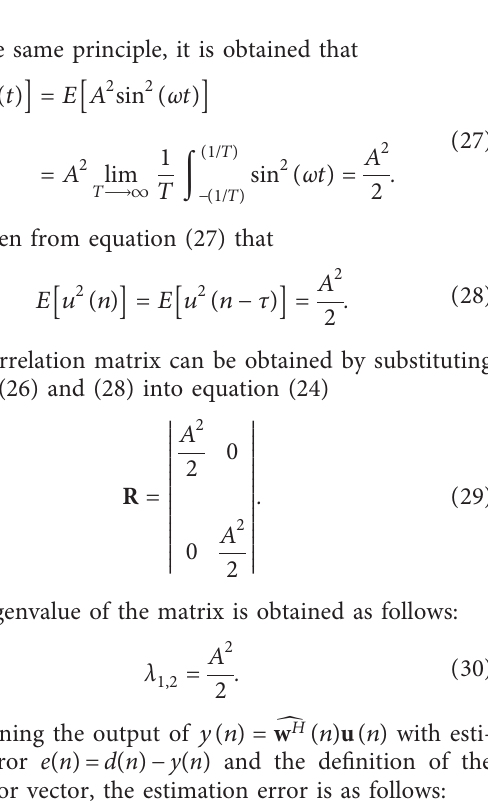
Figure 6: Controller with weight adjustment based on the adaptive